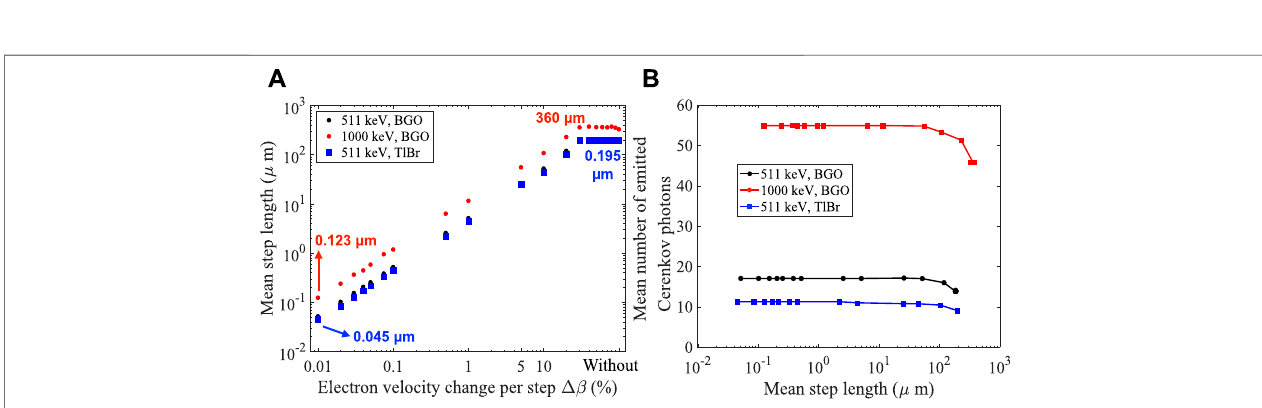
FIGURE 8 | Cerenkov photons (A) track length and (B) detection time distributions, for three electron mean step length values. Simulations were performed in a 20 mm thick BGO crystal, with the photodetector placed between the 511 keV gamma source and the crystal.